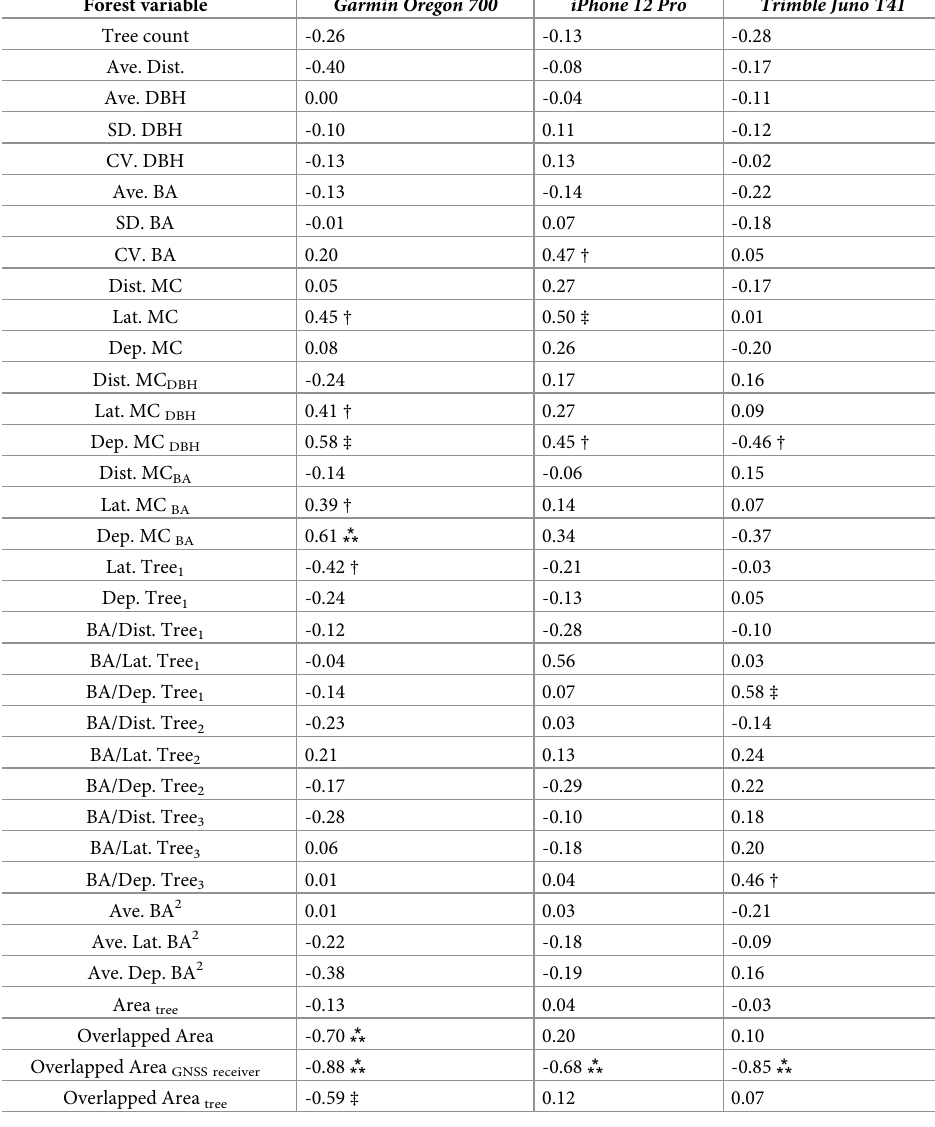
Table 5. A summary of Pearson correlation coefficients for RMSE and forest variables († p -value < 0.05; ‡ p - value < 0.01; ⁂ p -value <